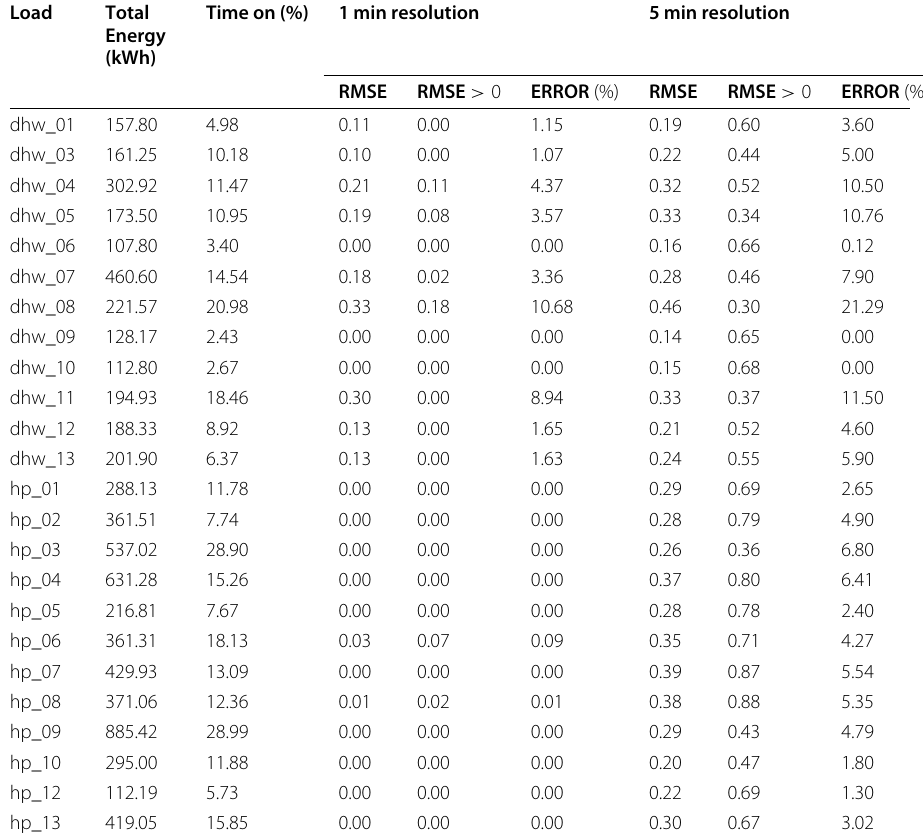
Table 3 Non intrusive load monitoring - comparing 1 and 5 minutes resolution